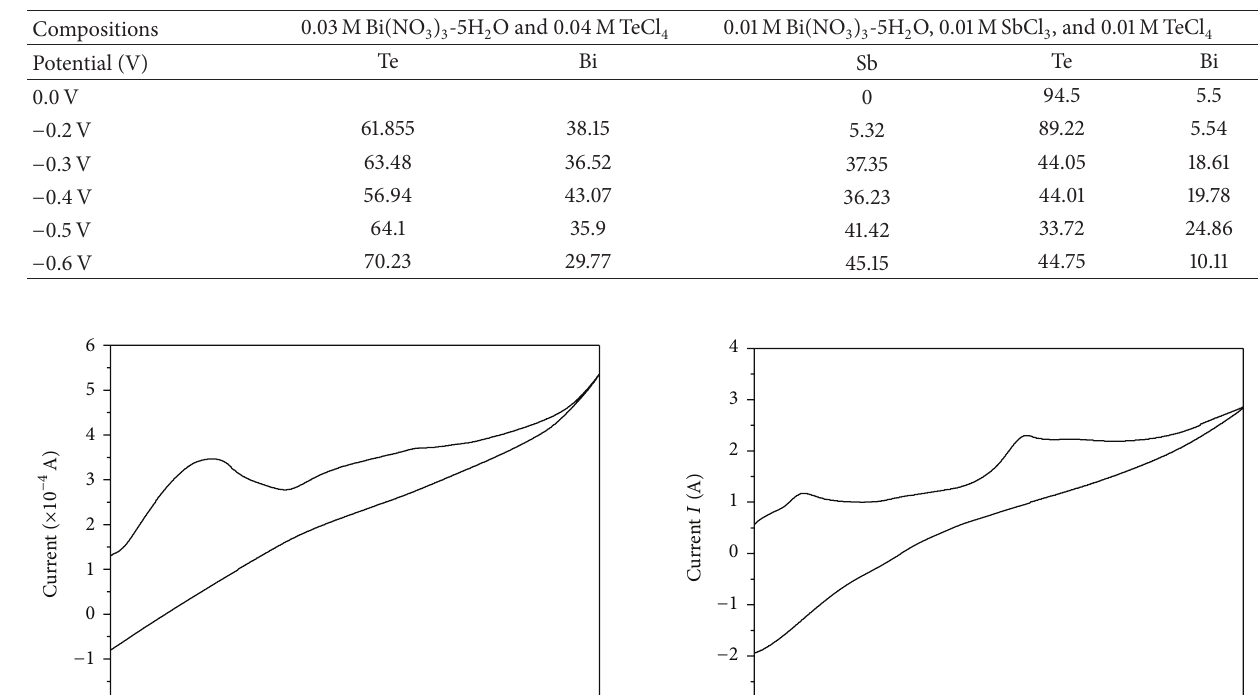
) -5H O, 0.01MSbCl 3 3 2